Question: Give a one-sentence summary of this figure.
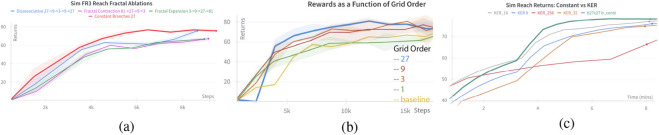
Answer: Fractal SERL results for simulated FR3 reach across five seeds. Mean shown in bold. The envelope shows one standard deviation. (a) Fractal Ablations. Showing performance between fractal variants: constant, expansion, contraction, and dissociated. (b) Fractal SERL returns as a function of grid size. (c) Comparison of Fractal SERL vs. Kaleidoscope Experience Replay reflectional symmetries ( Lin et al., 2020 ) for the SIM Reach task. Zoomed in for a better view.